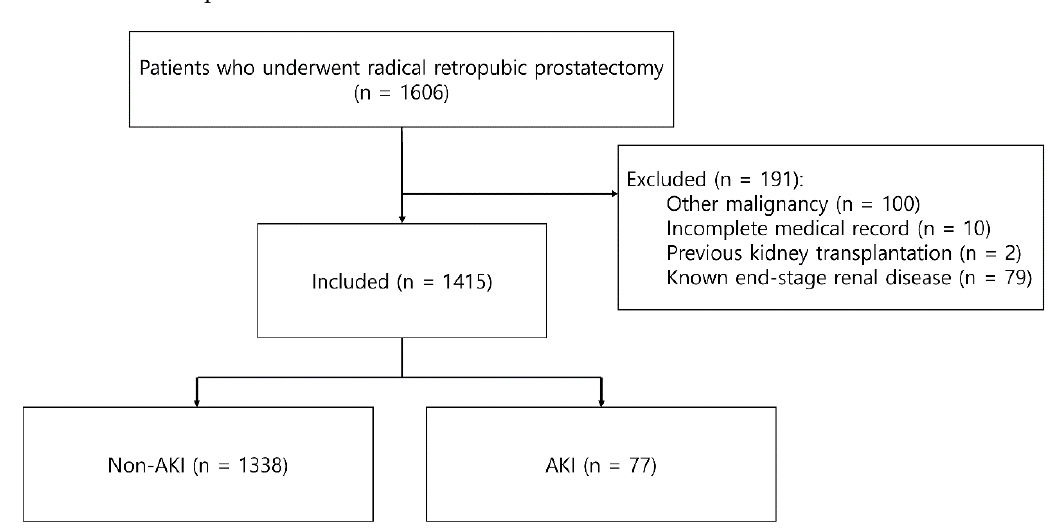
Figure 1. Flow of the study protocol. AKI, acute kidney injury.